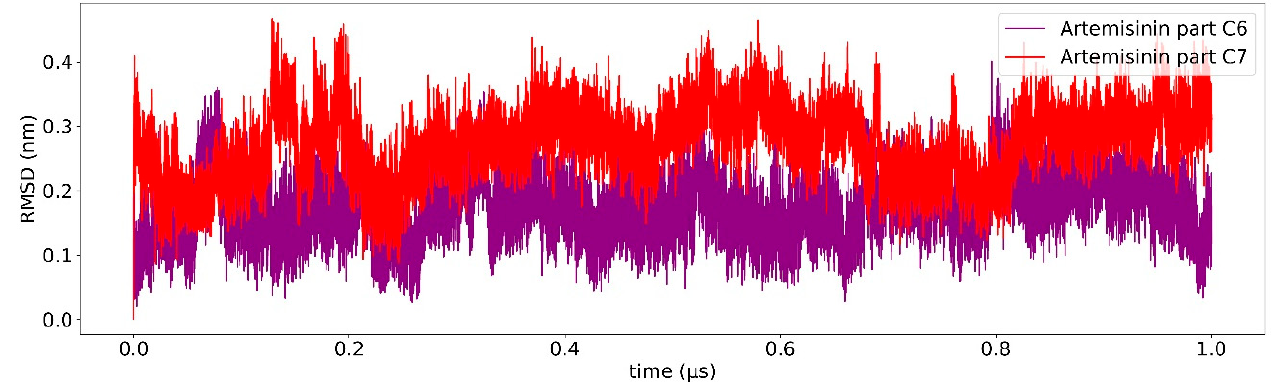
Figure 5. Root mean square deviation (RMSD) relative to 1 us of simulation. The RMSD of the artemisinin part of compound c6 is shown in purple, the artemisinin part of compound c7 is shown in red.